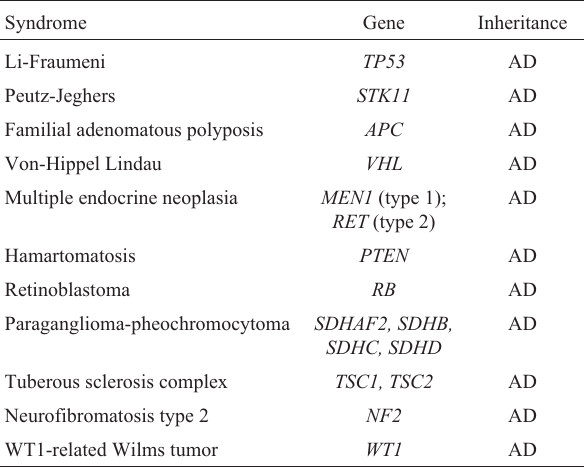
Table2 -ACMGlistofhereditarycancersyndromes,mostwithchildhood onset, for reporting incidental